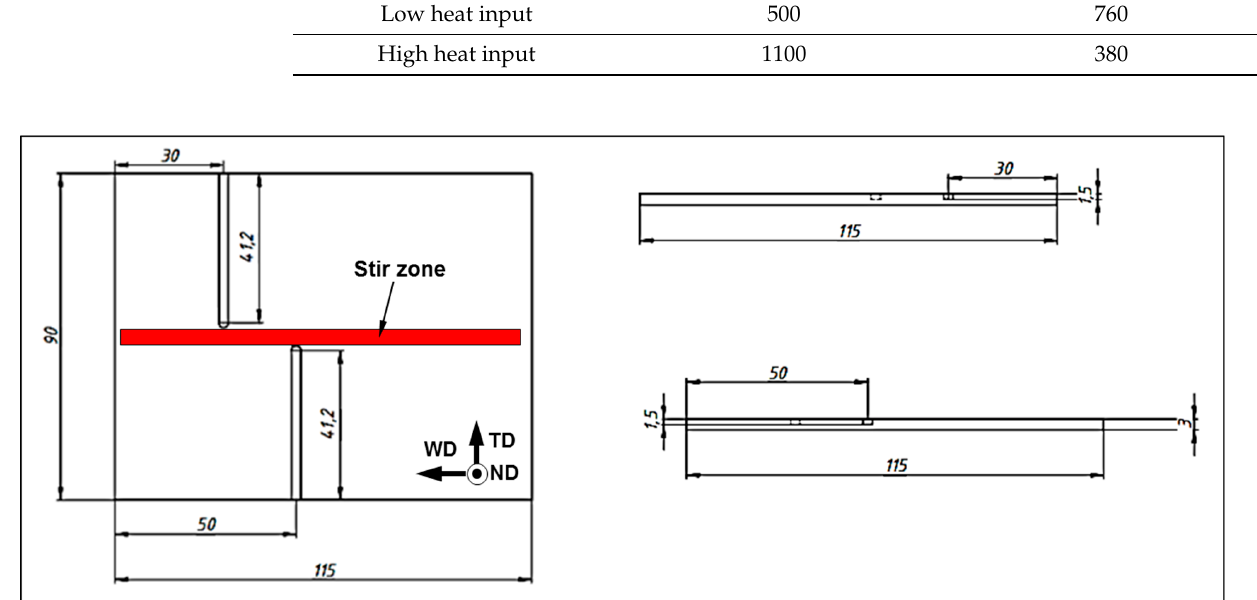
Figure 1. Thermocouple layout inside the workpiece (unit: mm). WD, ND and TD denote the welding direction, normal direction, and transverse direction. Not to scale.